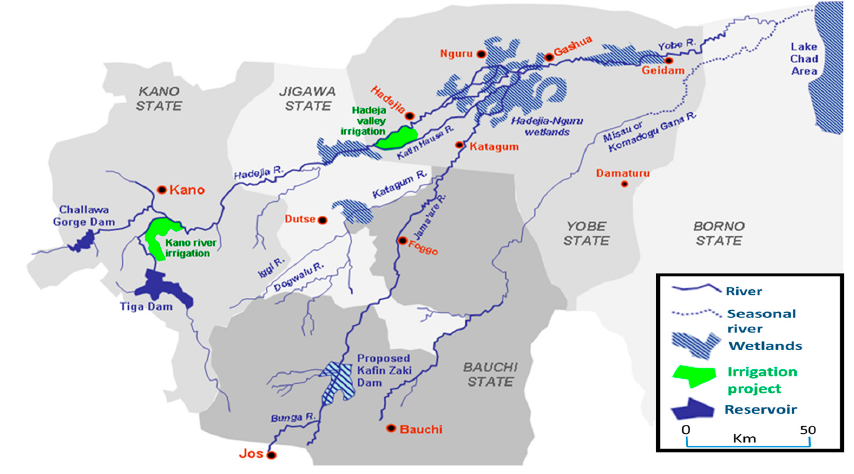
Figure 1. River Basins of Northern Nigeria.